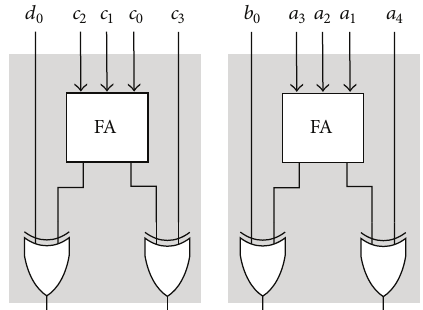
Figure 7: Covering of the combined network using 6-input dual LUTs.